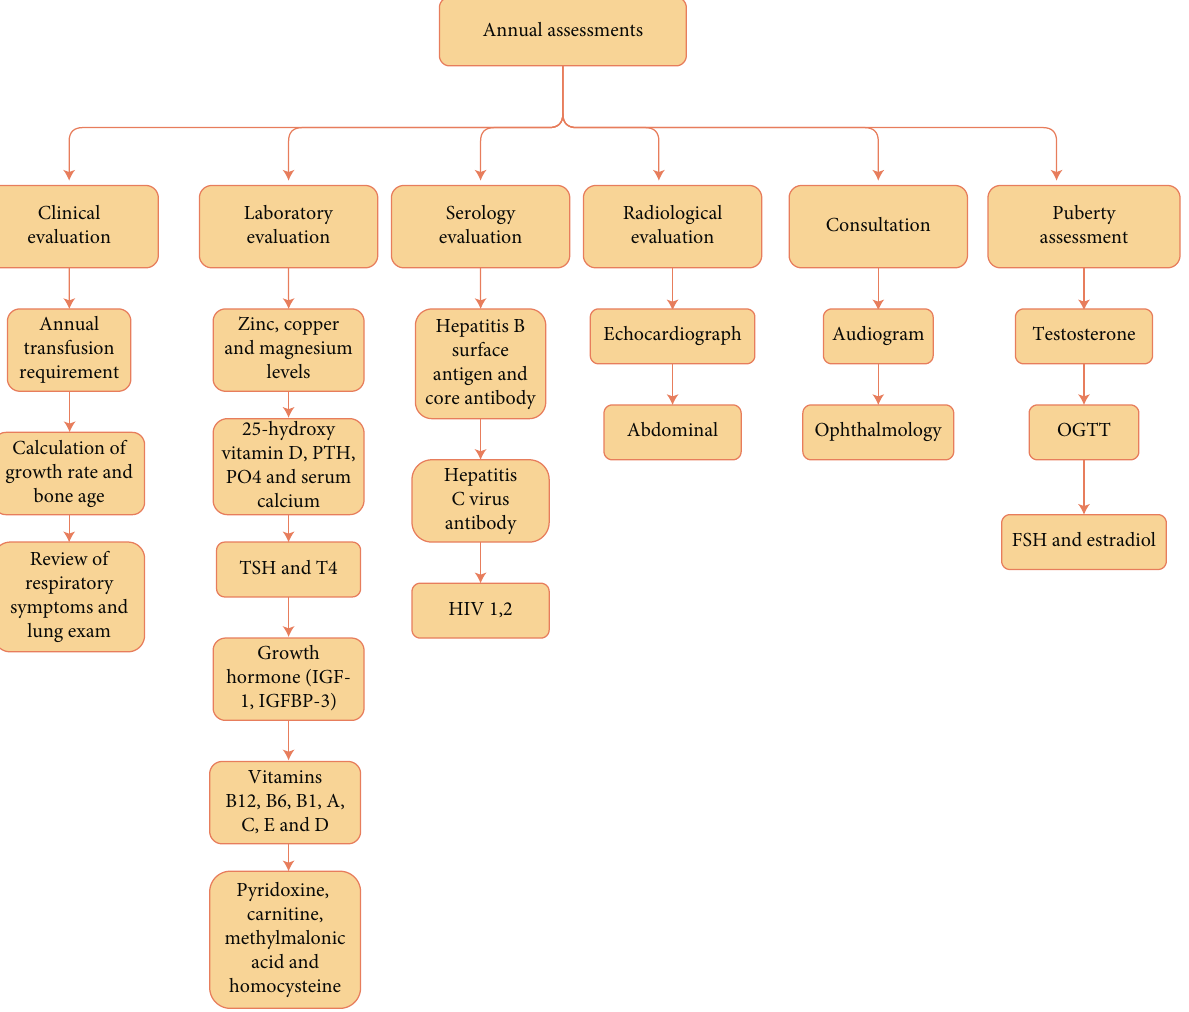
Figure 6: Semantic network representation of follow-up annual